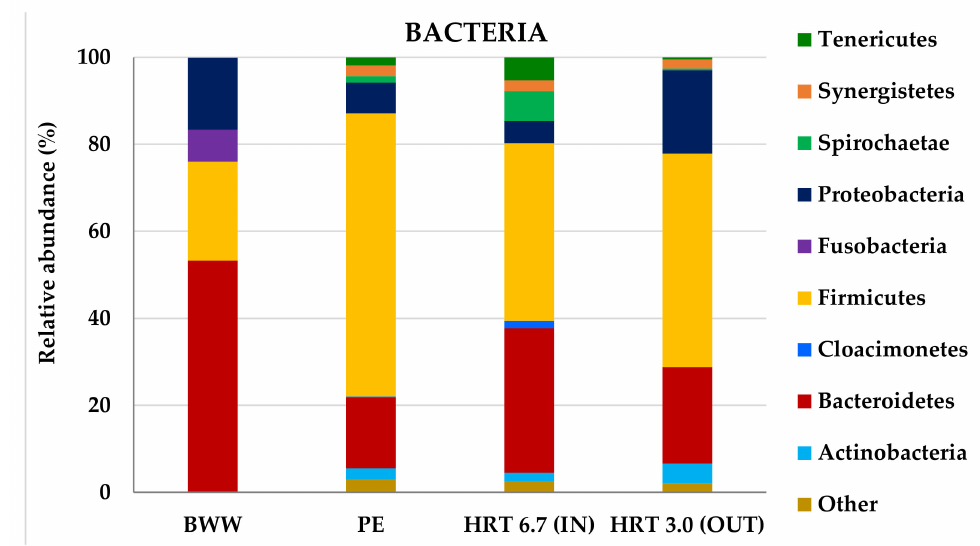
Figure 5. Relative abundance and dynamics of bacterial communities, taxonomic classification of bacterial reads at phylum level in samples collected at different operating conditions and efflu- ents. BWW—Brewery wastewater, PE—Piggery effluent, HRT—Hydraulic retention time, OUT— Operational taxonomical unit. Other phyla were not considered in this discussion due to their low presence (0.01–1.2%) in the community: Armatimonadetes; Atribacteria; BRC1; Candidatus Berkel- bacteria; Chlamydiae; Chlorobi; Chloroflexi; Cyanobacteria; Deinococcus-Thermus; Fibrobacteres; Hydrogenedentes; Lentisphaerae; Microgenomates; Nitrospinae; Parcubacteria; Planctomycetes; SR1 (Absconditabacteria); Saccharibacteria; TM6 (Dependentiae); Verrucomicrobia; WS6; and unidenti- fied